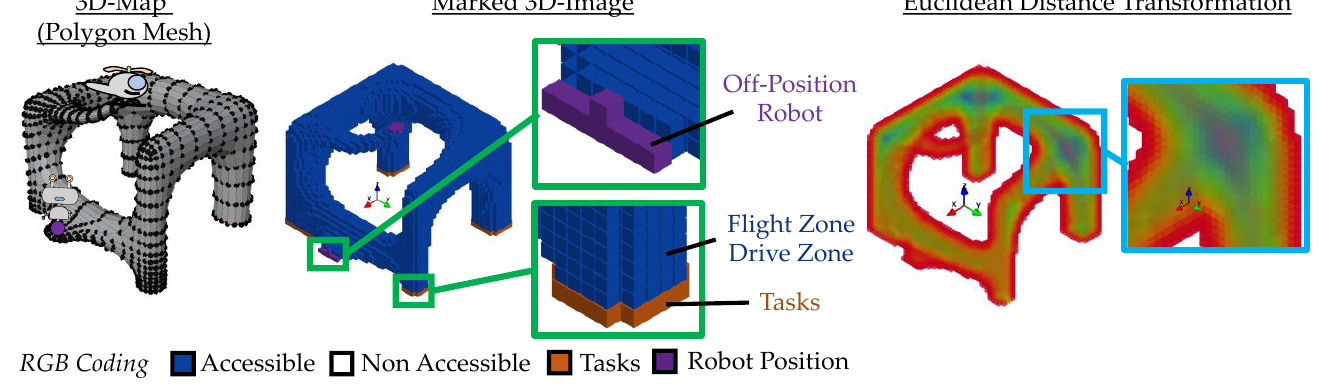
Figure 23. Drone and robot example with 3D flight and 3D drive zones: polygon mesh as flight zone and drivable zone, marked 3D map, Euclidean distance transformation of the flight and drive zone.